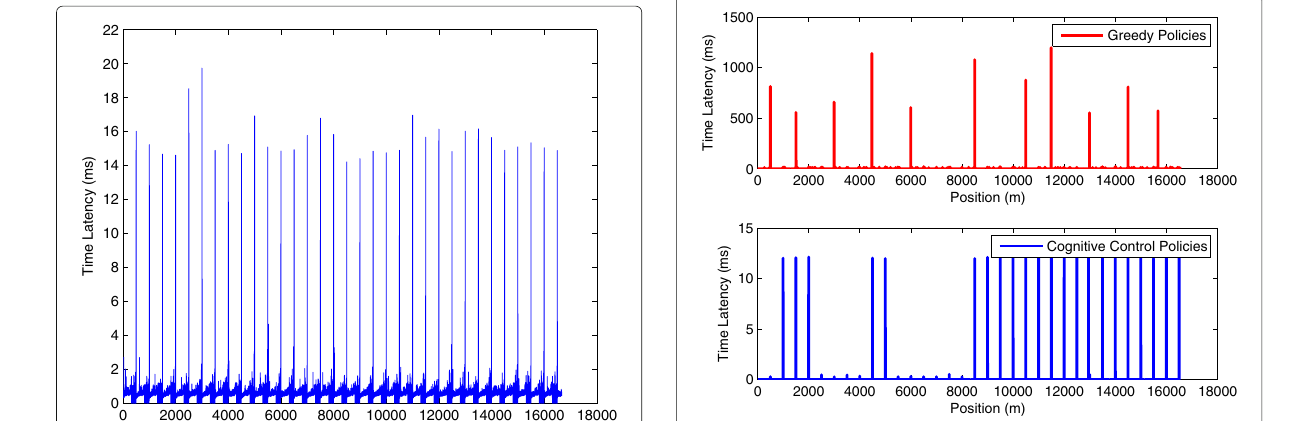
Fig. 15 Handoff latency under greedy policies and cognitive control